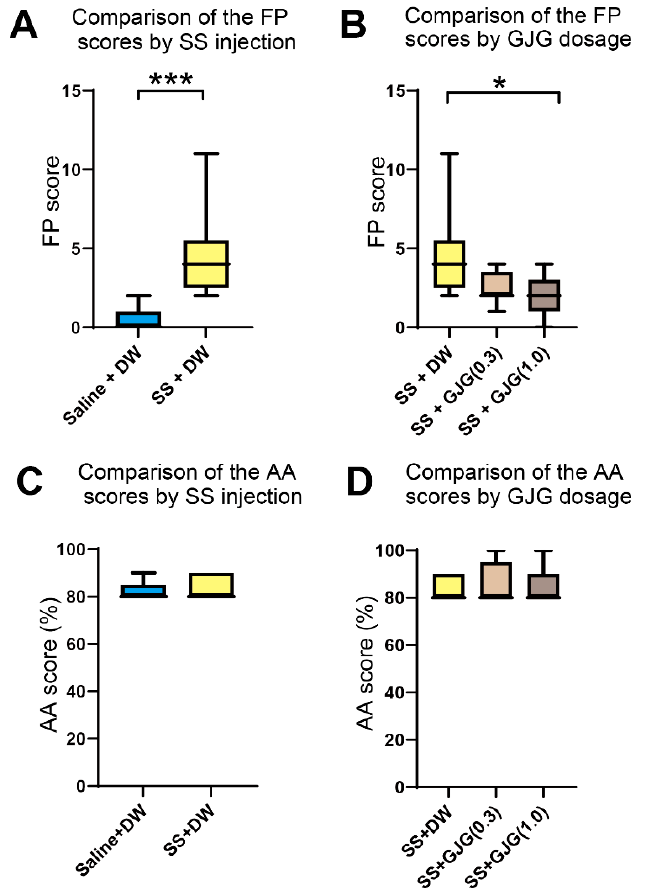
Figure 3. Effect of goshajinkigan (GJG) administration on false positive (FP) and active avoidance (AA) scores in salicylate-treated rats. ( A ) Comparison of FP scores between Saline + distilled water (DW) group and sodium salicylate (SS) + DW group ( n = 9 in each group). The FP scores in the SS + DW group were significantly higher than those in the Saline + DW group (*** p = 0.0002, Mann–Whitney U test). ( B ) Comparison of FP scores among three groups: SS + DW group, SS + GJG (0.3) group, and SS + GJG (1.0) group ( n = 9 in each group). The FP scores in the SS + GJG (1.0) group were significantly lower than those in the SS + DW group (* p = 0.021, Kruskal–Wallis test and Dunn’s test). No significant difference was observed between the SS + DW and SS + GJG (0.3) ( p = 0.275, Kruskal–Wallis test and Dunn’s test) or SS + GJG (0.3) and SS + GJG (1.0) groups ( p = 0.948, Kruskal–Wallis test and Dunn’s test). ( C ) Comparison of AA scores between the Saline + DW group and SS + DW group. Both groups showed AA scores ≥ 80% without significant differences. ( D ) Comparison of AA scores in three groups: SS + DW group, SS + GJG (0.3) group, and SS + GJG (1.0) group. All groups showed AA scores ≥ 80% with no significant group differences. Data are presented as median (interquartile range). A learning curve was created to show the progression of AA scores until these groups completed conditioning (see Supplementary Figure